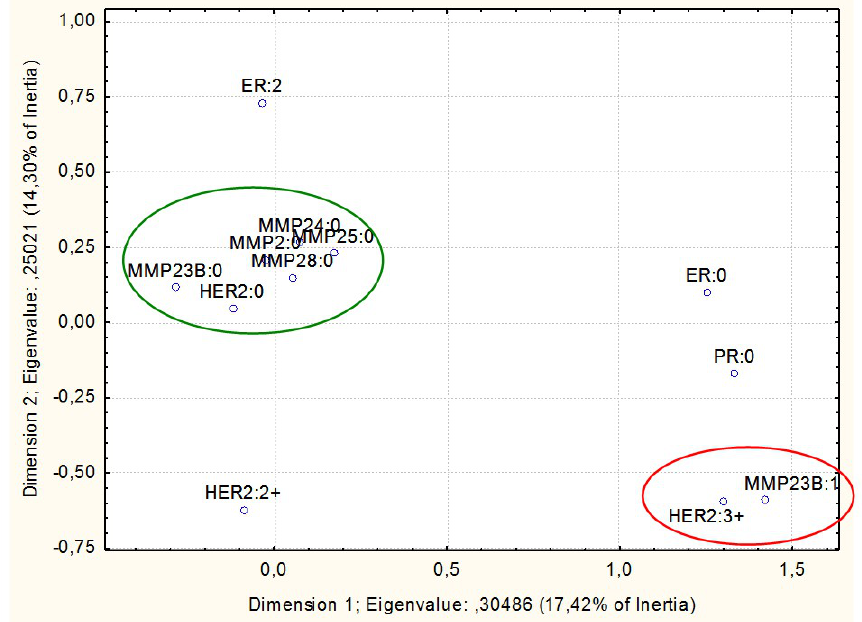
Figure 4. Results of multiple correspondence analysis of HER2 expression status vs. the methylation status of differentially methylated promoter CpG dinucleotides of matrix metalloproteinases genes in breast cancer samples. The non-methylated (designated as “0” at the gene symbol) status of MMP2, MMP23B, MMP24, MMP25 , and MMP28 differentially methylated promoter CpG dinucleotides is associated with lack of HER2 expression (green ellipse). The methylated status of MMP23B differentially methylated promoter CpG dinucleotides is associated with a high level (3+) of HER2 expression (red ellipse).